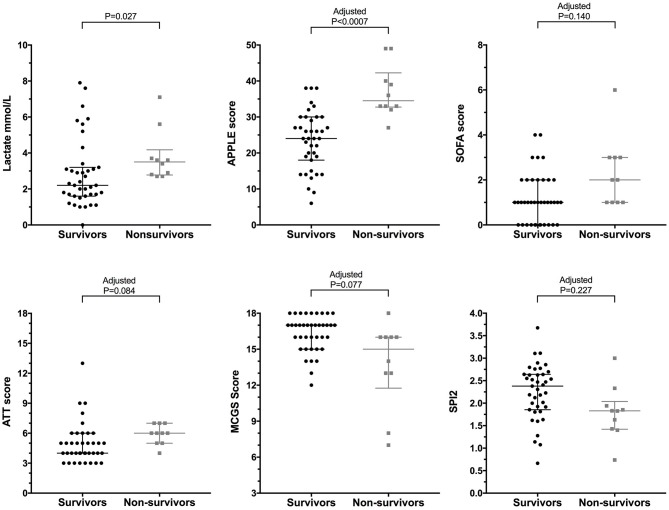
Scatterplots of lactate and illness severity scores from dogs following moderate-severe trauma grouped as survivors (•) (n = 39) vs. non-survivors () (n = 10). The central horizontal line represents the median, and the two error bars represent the interquartile range. Comparisons between the groups were performed using the Mann-Whitney U test. P < 0.05 was considered significant. P-values for illness severity score comparisons were adjusted using the Bonferroni correction (n = 7 comparisons), as indicated.